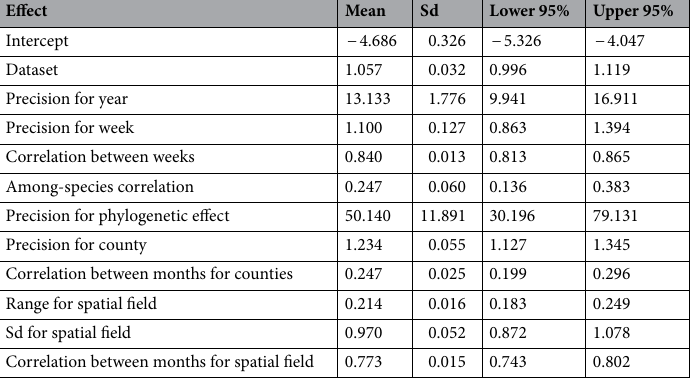
Table 2. Untransformed model effects giving the mean, standard deviation (Sd) and lower and upper 95% credible intervals of the